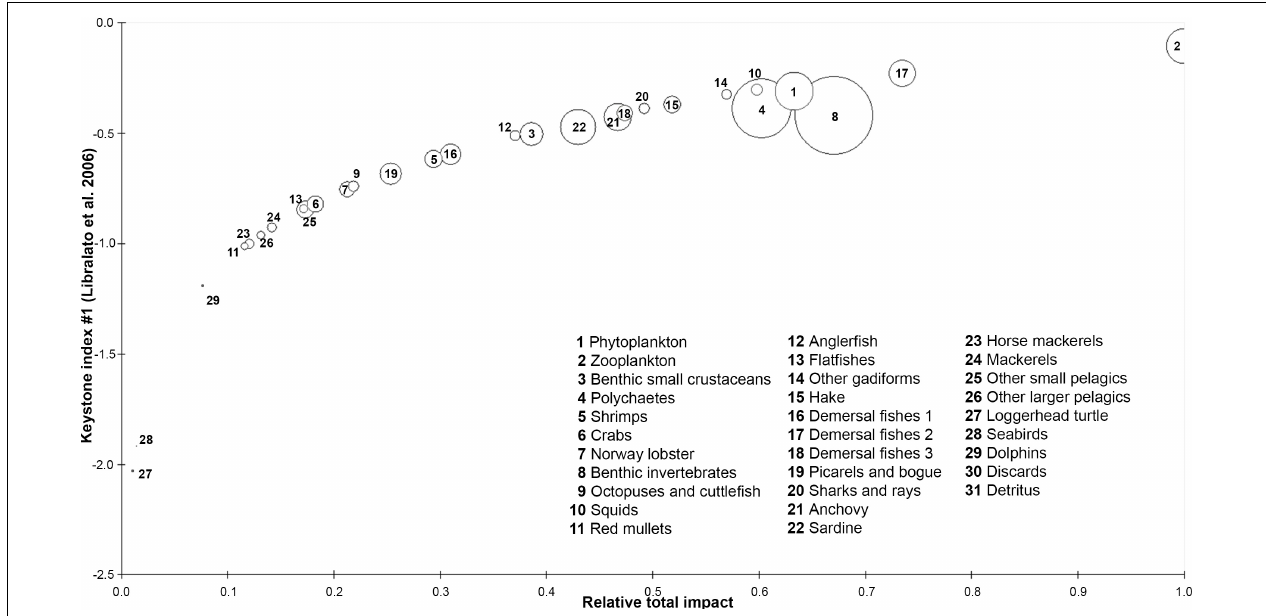
FIGURE 4 | Keystone index and relative total impact of each functional group of the Pagasitikos Gulf model. Circle size indicates the % relative biomass of each group.